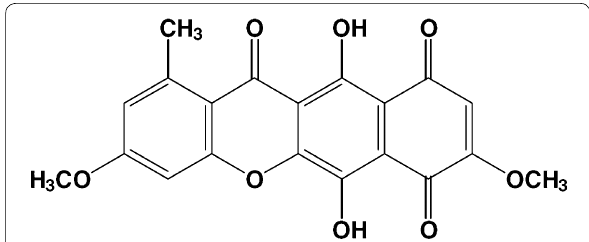
Fig. 1 Chemical structure of bikaverin, as described by Cornforth et al.